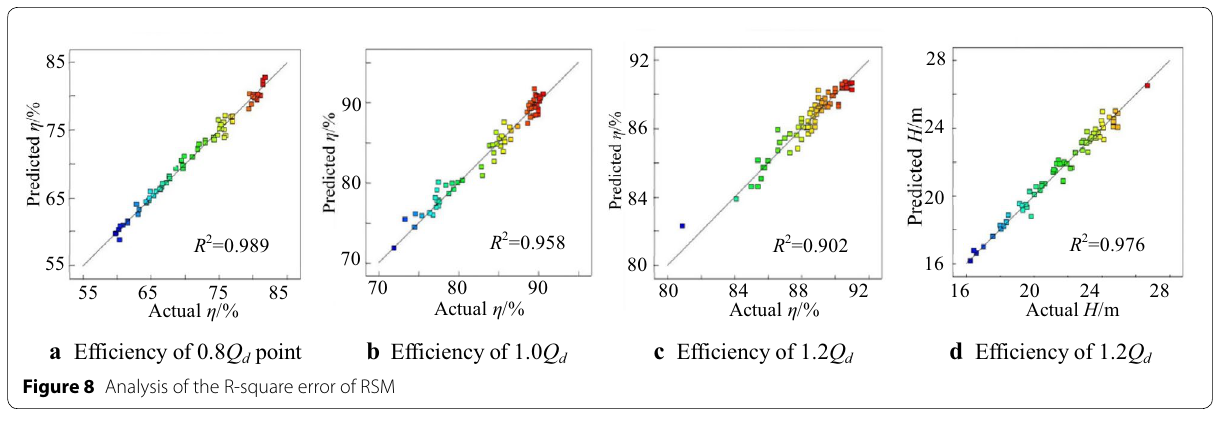
Figure 8 Analysis of the R‑square error of RSM